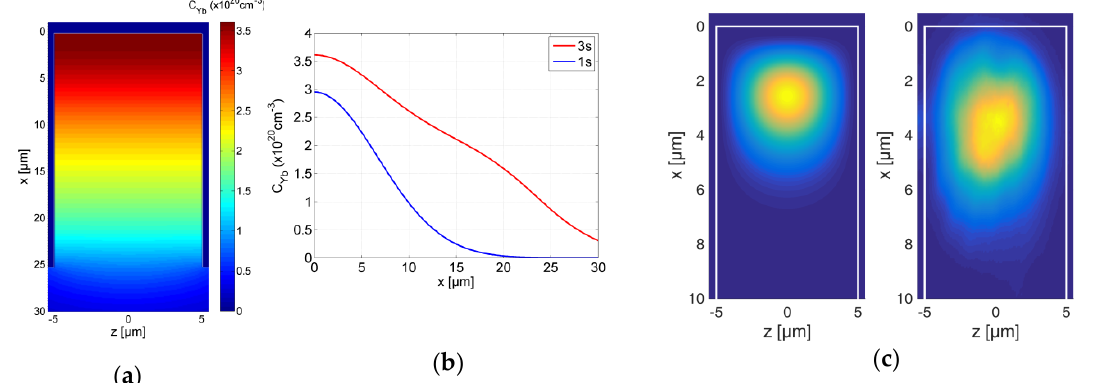
Figure 7. ( a ) Simulated Yb profile in LiNbO 3 for the in-di ff usion of two 22 nm thick layers evaporated under ± 60 ◦ and in-di ff used for 216 h at 1125 ◦ C. ( b ) The Yb profile in x-direction in the middle of the ridge (red line). The results for a plane layer of Yb di ff used in from the surface only are included as a blue line. ( c ) Simulated (left) and measured (right) intensity distribution for the fundamental mode at 980 nm for a 10 µ m-wide ridge-waveguide formed by three-side Ti in-di ff usion.